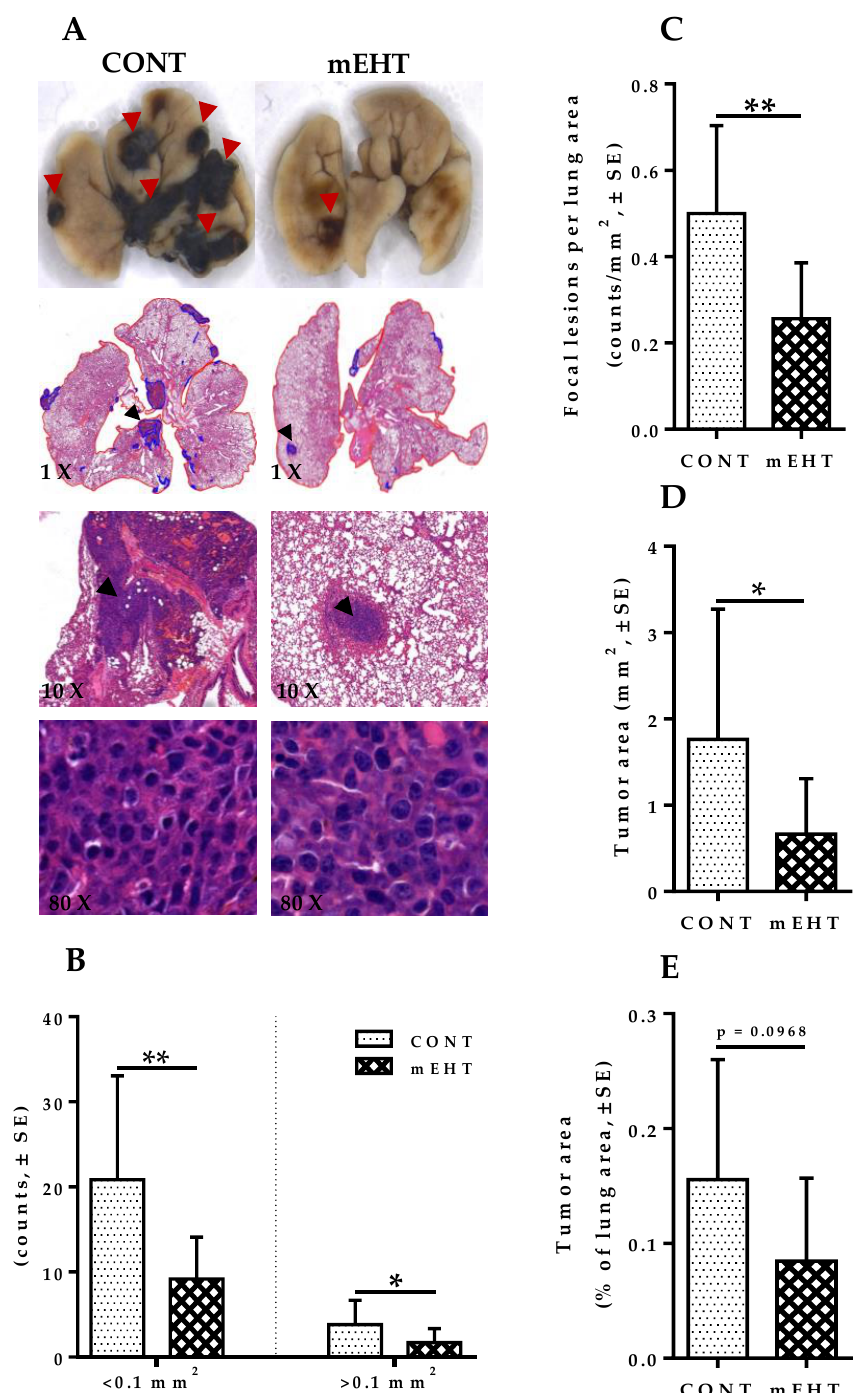
Figure 4. Inhibitory e ff ect of modulated electrohyperthermia on tumor growth and proliferation. ( A ) Native and H&E-stained lungs with pulmonary melanoma metastases at higher magnification in CONT and mEHT-treated animals. ( × 80) magnification demonstrates the absence of any observable tumor necrosis after six-time treatment with mEHT; ( B ) Cumulative counts of focal metastatic melanoma lesions in CONT ( n = 12) and mEHT ( n = 10) sorted based on size ( < 0.1 and > 0.1 mm 2 ); ( C ) Cumulative counts of focal metastatic melanoma lesions per total lung area in CONT ( n = 12) and mEHT ( n = 10); ( D ) Tumor area occupied by melanoma in lungs in CONT ( n = 12) and mEHT ( n = 10); ( E ) Tumor area per total lung area in CONT ( n = 12) and mEHT ( n = 10). Data represent average ± SEM. unpaired t -test, * p < 0.05, ** p < 0.01.